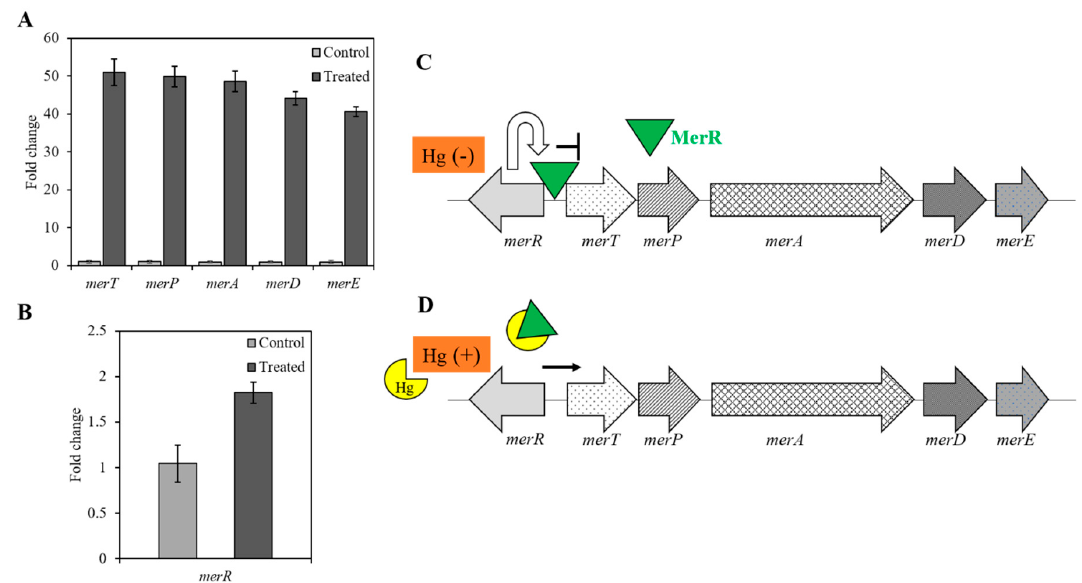
Figure 4. The transcription profile of mer determinants upon Hg exposure in strain MA5. Graphs show fold change value obtained after qRT-PCR analysis of and merT, merP, merA, merD, and merE ( A ) merR ( B ) in the absence and presence of 5 µ g / mL Hg. The assay was performed in triplicate and values are shown with error bars depicting standard deviation. P values were calculated using one-way ANOVA analysis to calculate the significant di ff erence between control v / s treated cells. The P value was < 0.001 for merT, P, A, D, and E, and < 0.03 for merR . Schematic showing MerR mediated regulation of mer operon in the absence ( C ) and the presence of Hg ( D ).